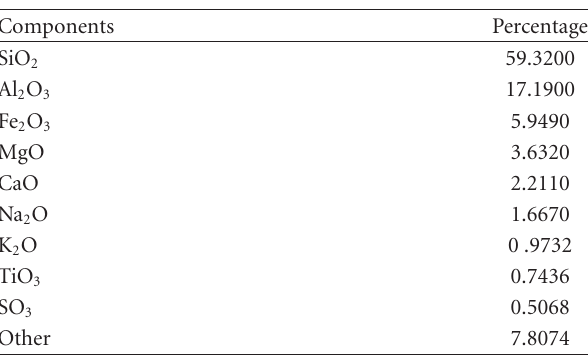
Table 1: Chemical composition of the